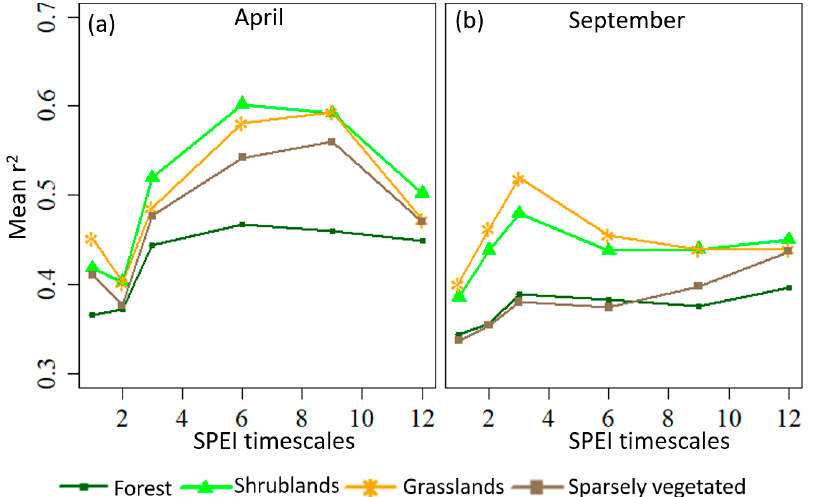
Figure 10. Mean coefficient of variation (r 2 ) computed from the correlation matrices of NDVI and different SPEI timescales based on different vegetation types for the overall study area (i.e., without ecoregions) for April (winter: a ) and September (summer: b ).